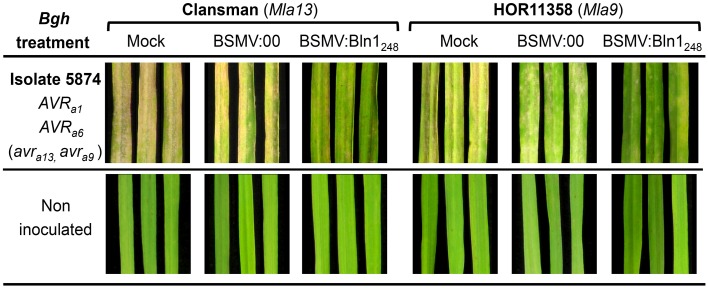
Barley1 GeneChip expression profiling design and phenotypes upon
Bgh
infection. Transcript profiling was based a split-plot design with 5 replications as blocks, Bgh treatment as the whole-plot factor, and all combinations of genotype [cv. Clansman (Mla13) and cv. HOR11358 (Mla9)] and VIGS treatment [Buffer control (mock), BSMV:00 (empty vector), and BSMV:Bln1248] as the split-plot factor for a total of 60 Barley1 GeneChip hybridizations. Seven-day-old plants were treated with Mock, BSMV:00, and BSMV:Bln1248. Twelve days after buffer and BSMV treatments, plants were inoculated with the compatible Bgh isolate 5874 (AVRa1, AVRa6, avra9, avra13), or non-inoculated. Leaves were harvested at 32 h after Bgh inoculation. Five leaves for each treatment were used for phenotyping 7 days after Bgh inoculation.